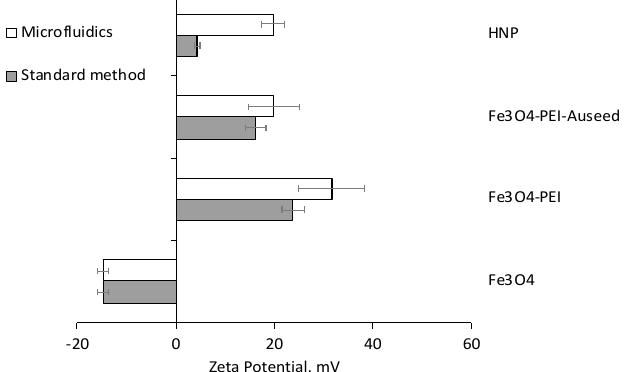
Figure 2. Zeta potential measurement of samples produced using standard laboratory synthesis and microfluidics ( n = 3 ± SD).